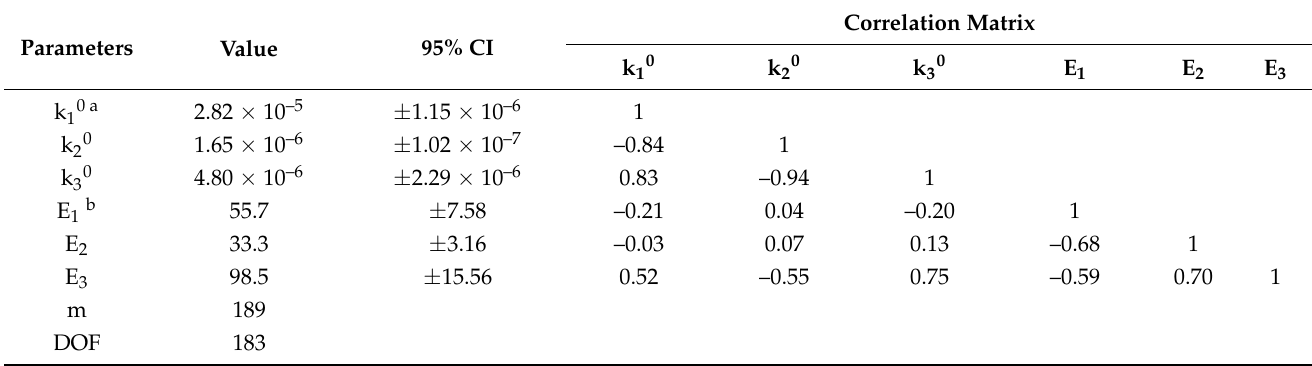
Table 4. Intrinsic Kinetic Parameters with their 95% Confidence Intervals (CIs) Adapted from